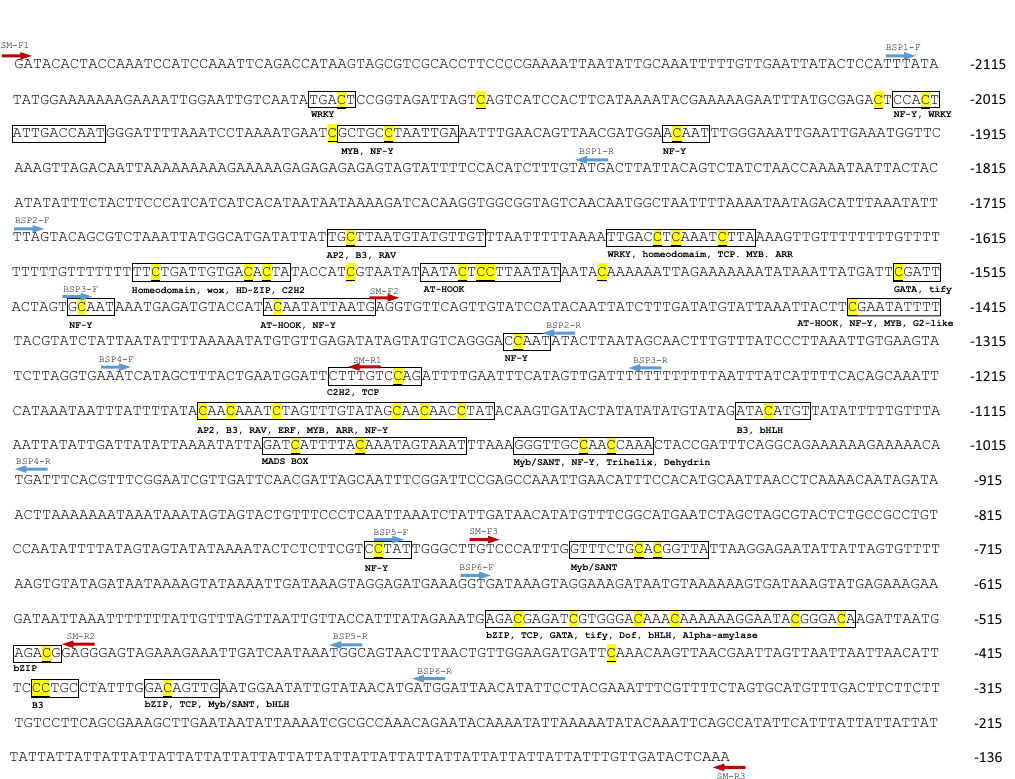
GATACACTACCAAATCCATCCAAATTCAGACCATAAGTAGCGTCGCACCTTCCCCGAAAATTAATATTGCAAATTTTTGTTGAATTATACTCCATTTATA